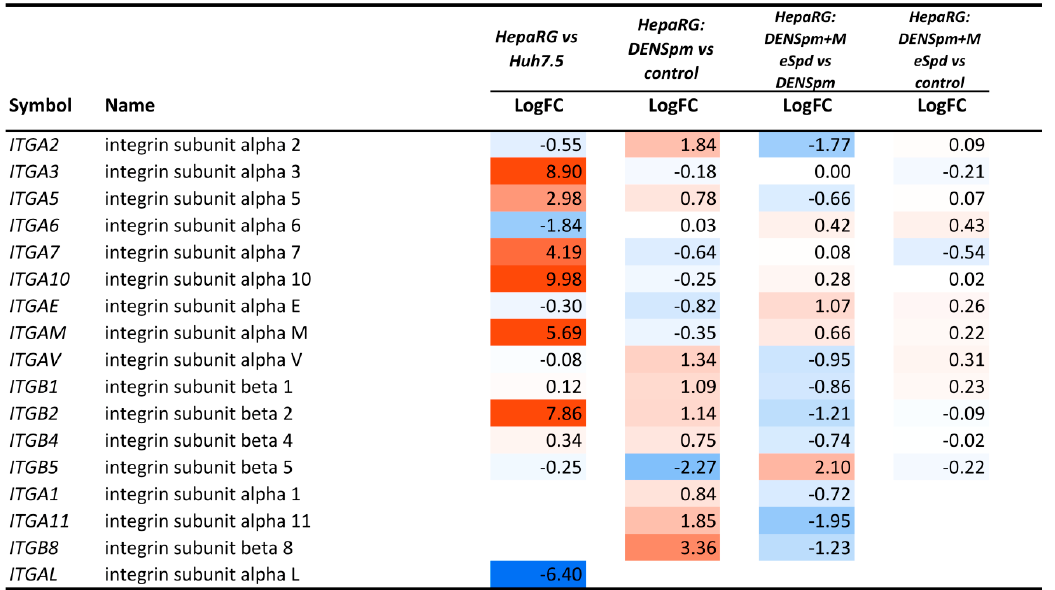
Figure 10. Expression of genes encoding integrins in four comparisons: (a) HepaRG vs. Huh7.5 cells (HepaRG vs. Huh7.5); (b) DENSpm-treated HepaRG vs. non-treated HepaRG cells (HepaRG: DENSpm vs. control); (c) DENSpm+MeSpd-treated HepaRG cells vs. DENSpm-treated HepaRG (HepaRG: DENSpm+MeSpd vs. DENSpm); (d) DENSpm+MeSpd-treated HepaRG cells vs. non-treated HepaRG cells (HepaRG: DENSpm+MeSpd vs. control). LogFC—binary logarithm of expression level fold change.